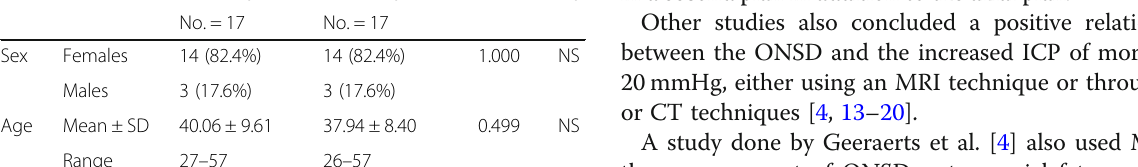
Table 1 Demographic data of the study participants Control